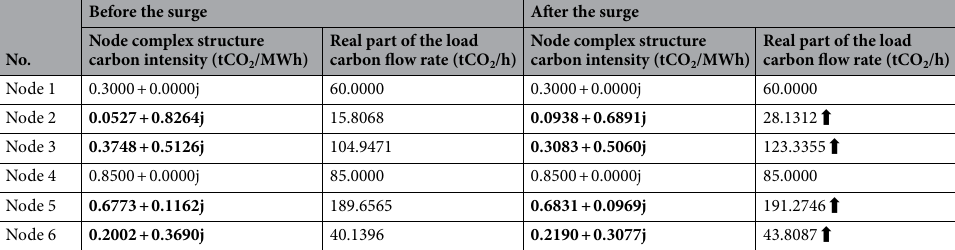
Table 4. Carbon intensity and complex structure carbon intensity in 6-bus test system. Significance values are in bold.